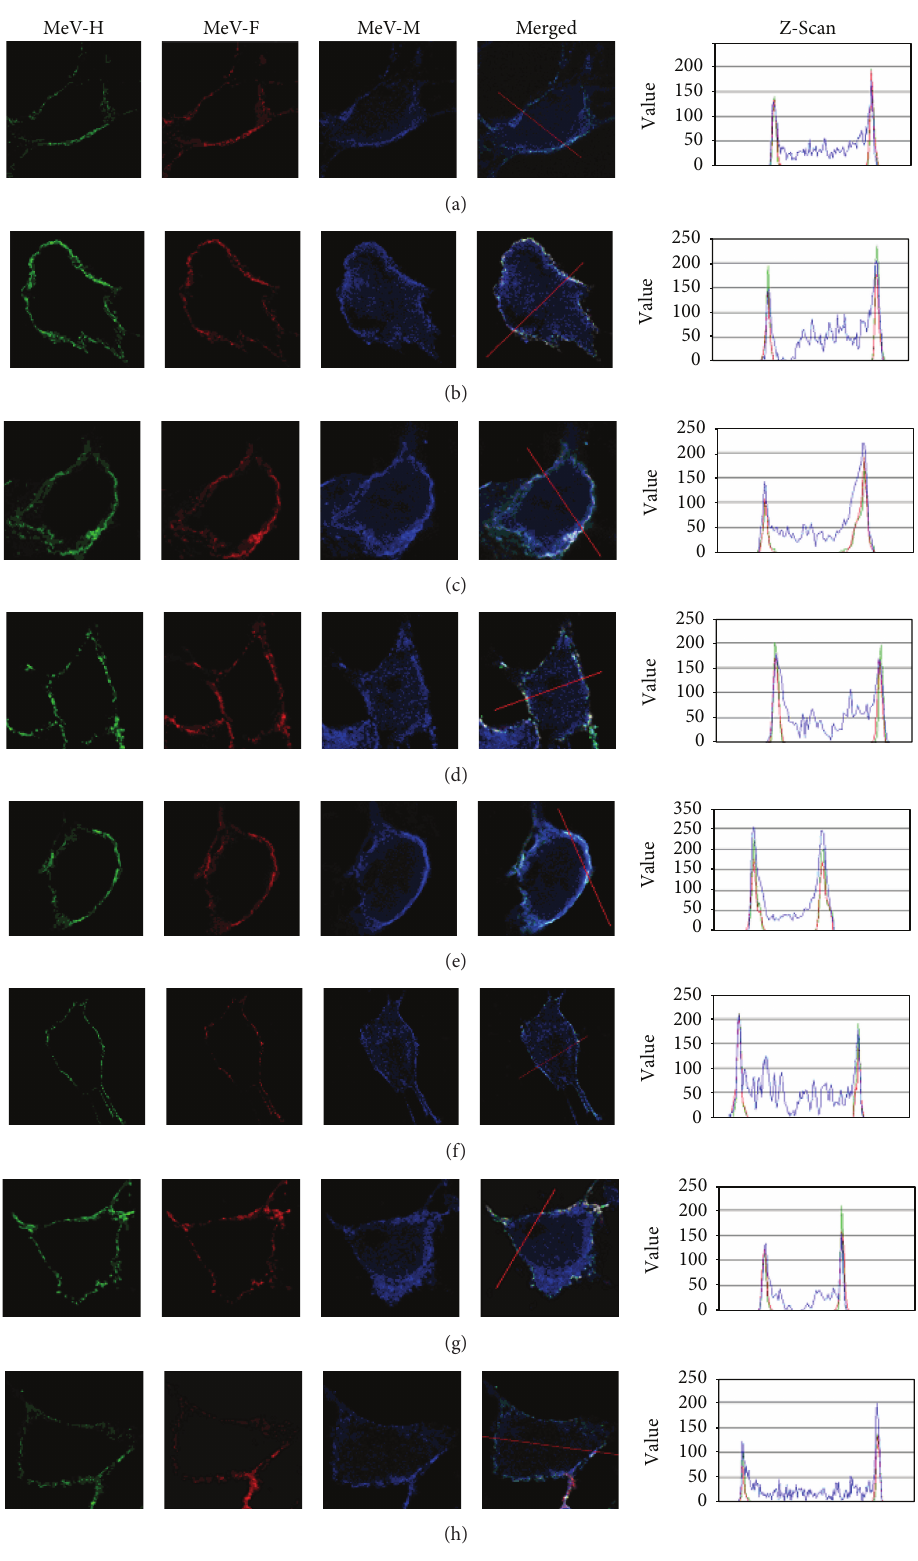
Figure 5: Confocal study of localization of MeV proteins, H, F, and M, of Moraten recombinant viruses. Vero-SLAM cells infected with these recombinant viruses were stained with anti-H labeled with Alexa Fluor 488, anti-F mAb Y503 with Alexa Fluor 555, and anti-M mAb8910 with Alexa Fluor 647. (a) SKT; (b) PKT; (c) SET; (d) SKA; (e) PET; (f) PEA; (g) S(R)KT; (h)